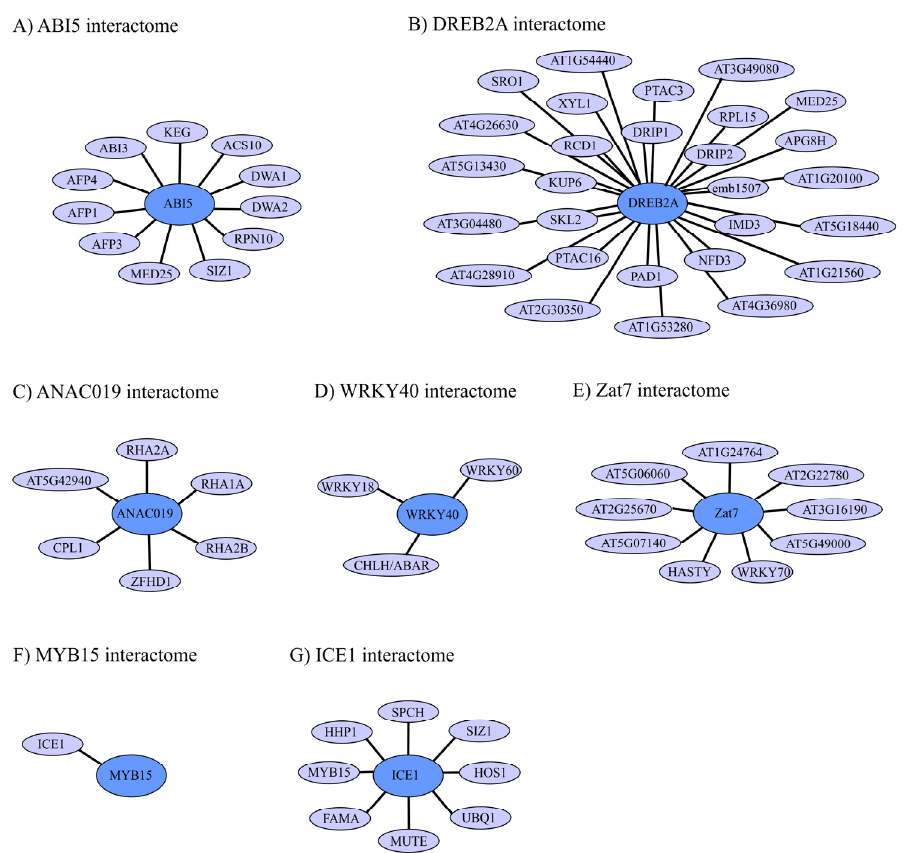
Figure 3. Arabidopsis interaction networks with different abiotic stress-related TFs as hub. The interactomes are visualized from the N-Browse viewer (http://www.arabidopsis.org/tools/nbrowse.jsp) [169] with manual modifications